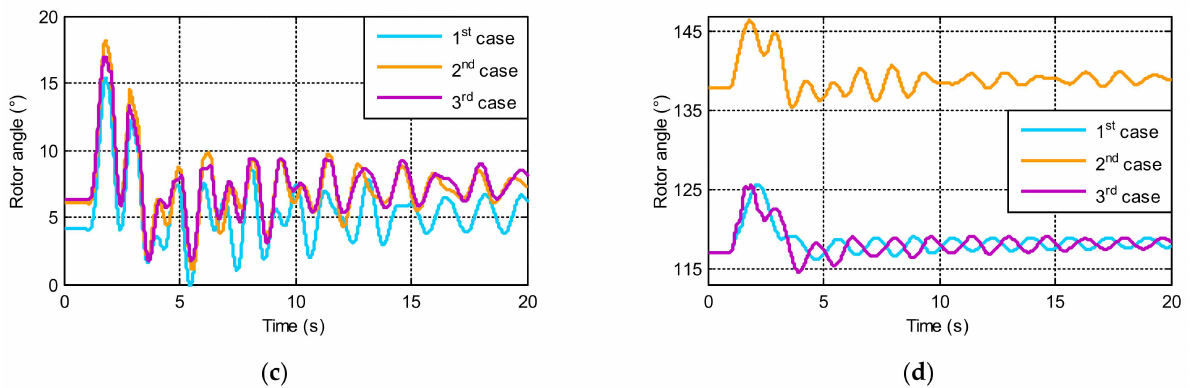
Figure 11. Transient response of the studied power system versus a simultaneous line and bus distur- bance for studied test cases: ( a ) spread angle; ( b ) average angle; ( c ) smallest angle; ( d ) largest angle.